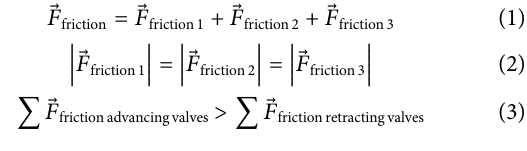
Frontiers in Bioengineering and Biotechnology |